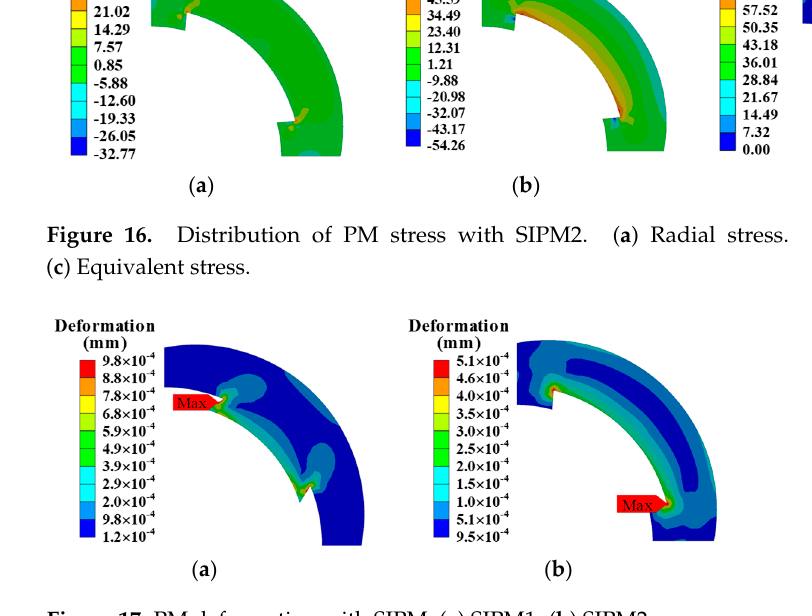
Figure 17. PM deformation with SIPM. ( a ) SIPM1. ( b ) SIPM2.